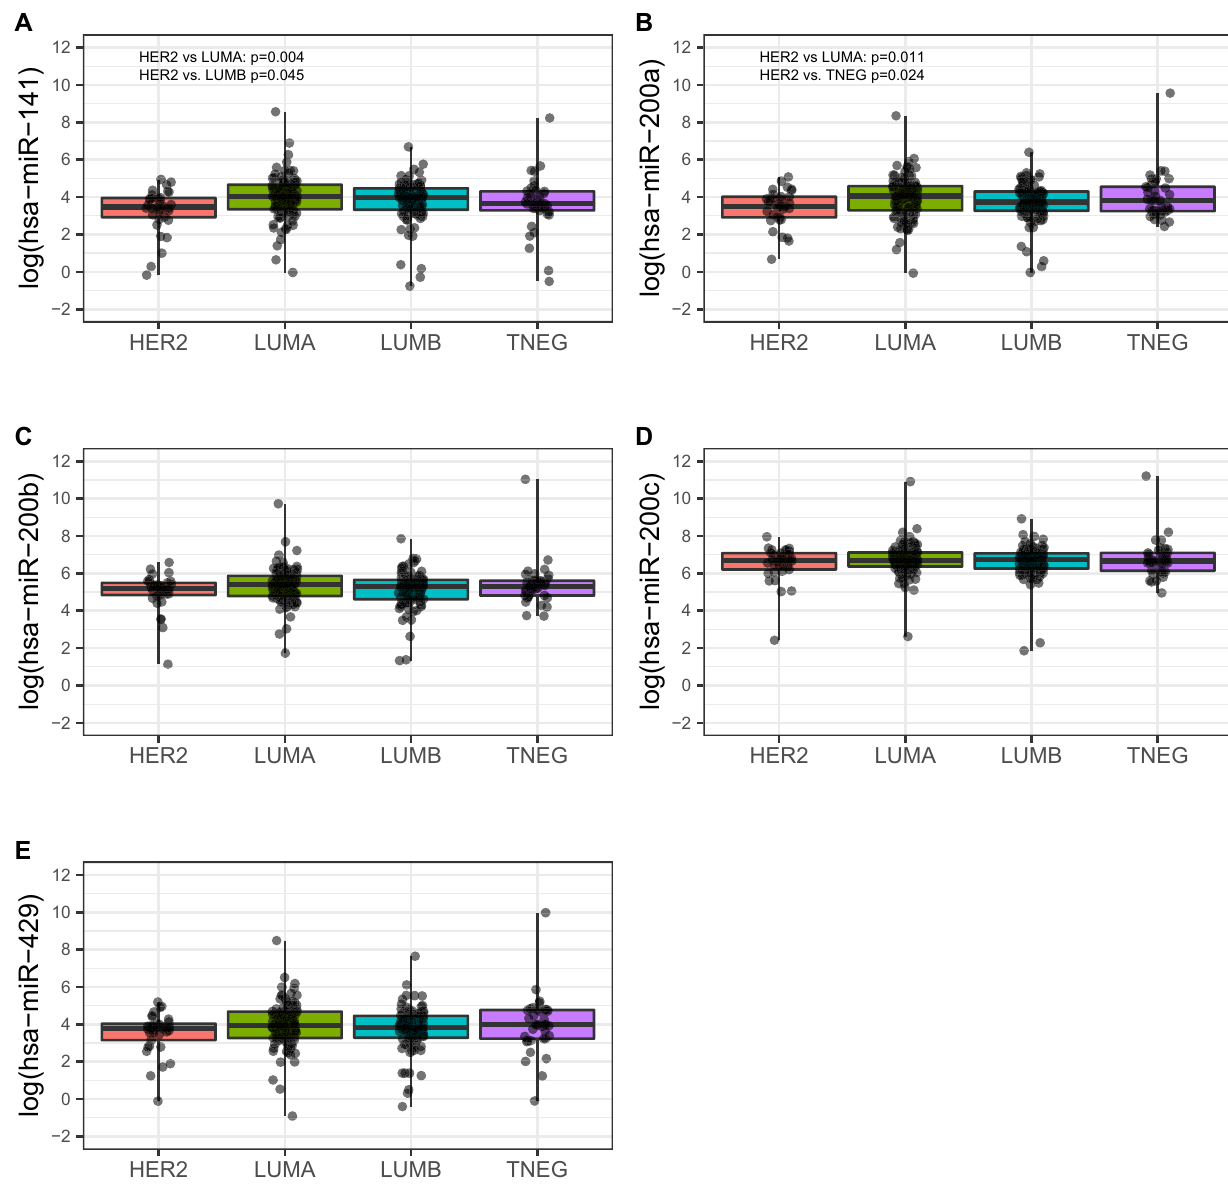
Figure 3. miR-200 family members expression within the surrogate molecular classification subgroups identified in the H-CSS cohort: HER2 amplified tumors (HER2), Luminal A (LUMA), Luminal B (LUMB), Triple Negative (TNEG). Plots were performed using the R Foundation for Statistical Computing (version 3.6, packages: ggplot2,